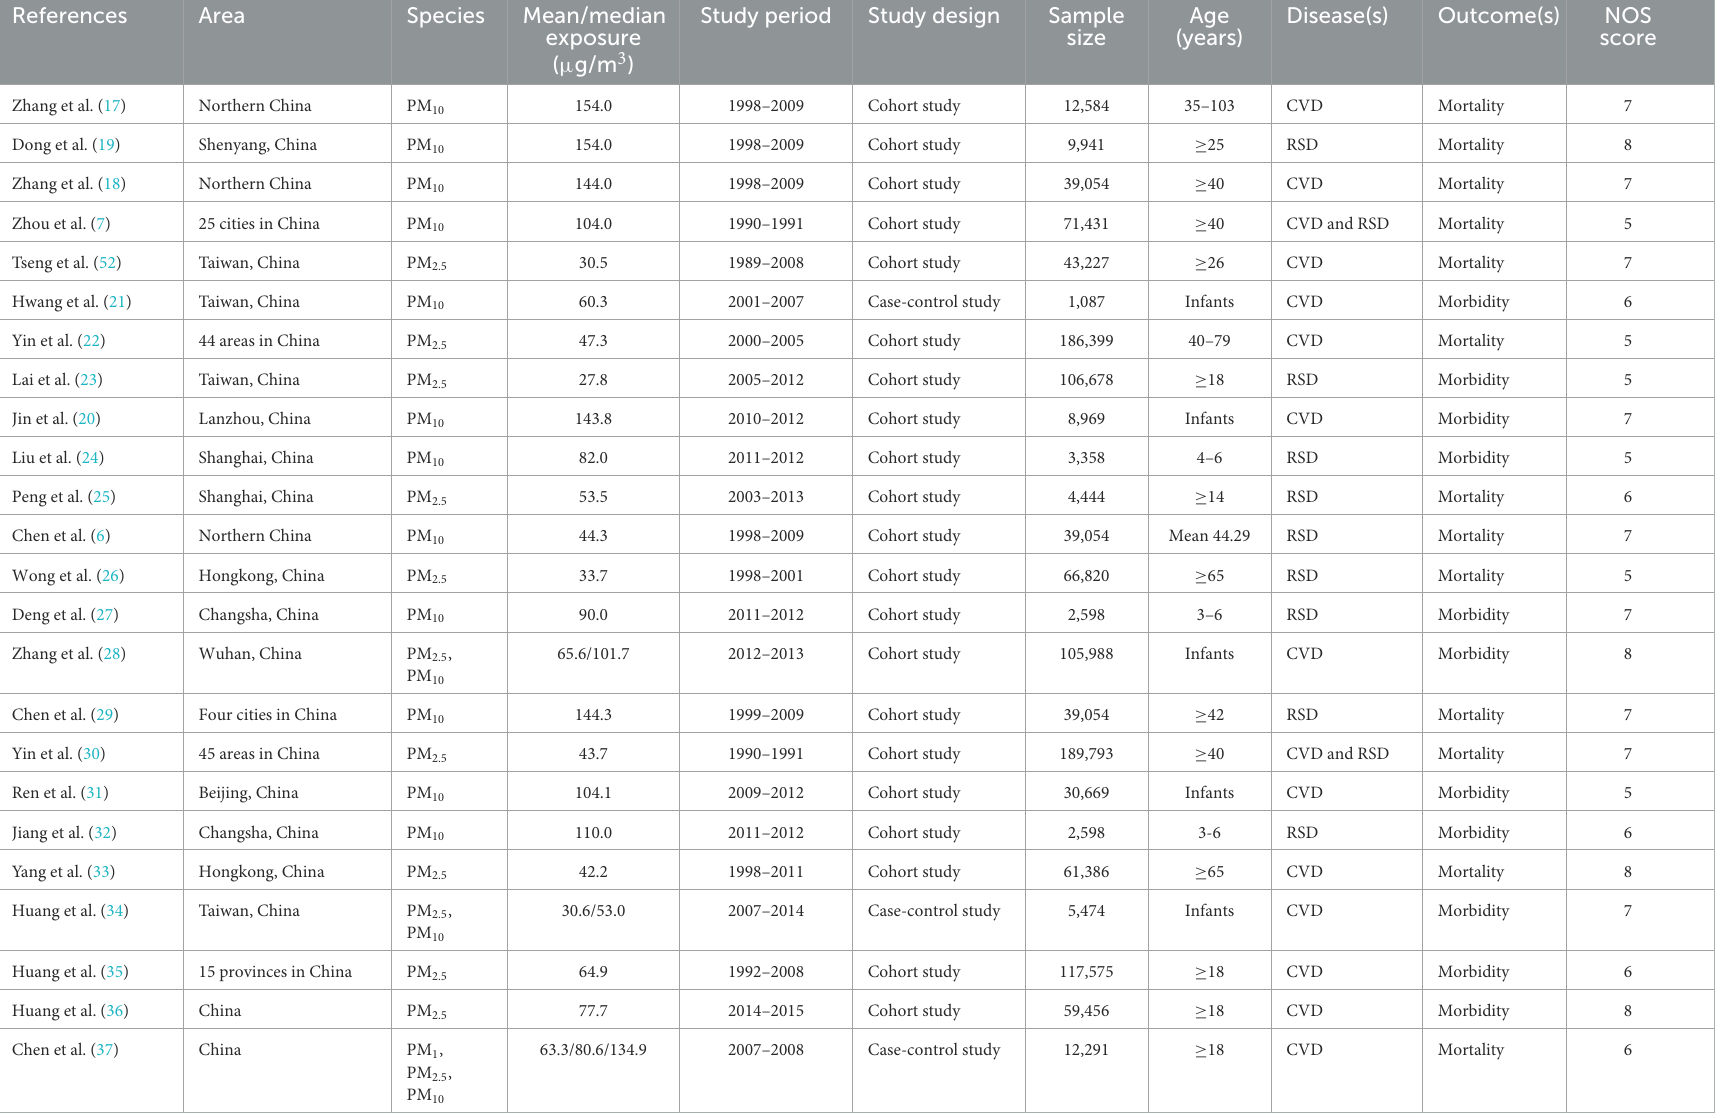
TABLE 1 Features of the included studies regarding long-term PM